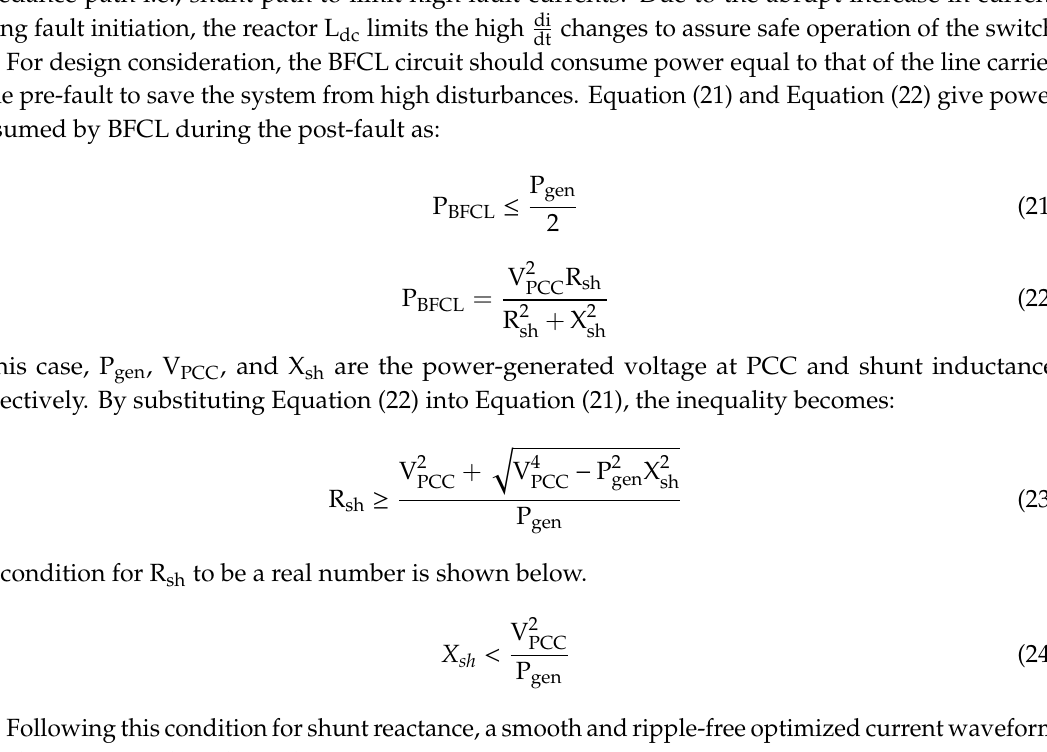
Figure 7. BFCL circuitry.